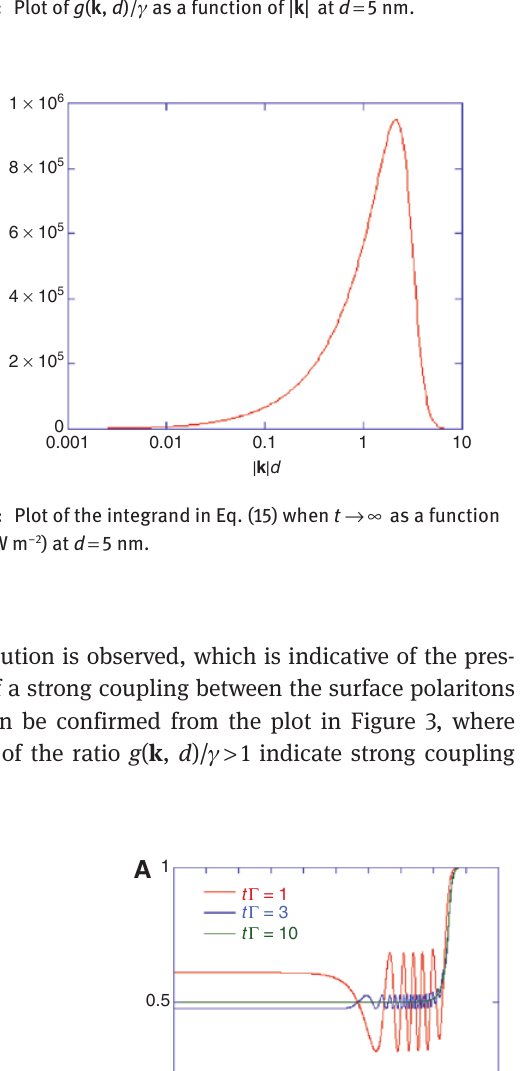
Figure 3: Plot of g ( k , d )/ γ as a function of | k | at d = 5